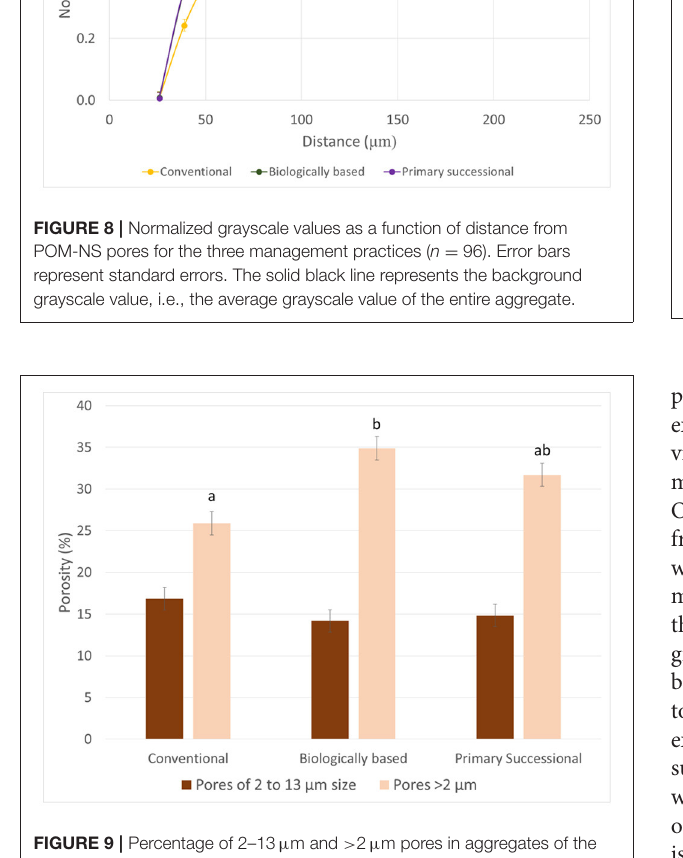
FIGURE 9 | Percentage of 2–13 µ m and > 2 µ m pores in aggregates of the three managements. Letters indicate significant differences between managements for > 2 µ m pores at α = 0.05. The differences in 2–13 µ m pores were not statistically significant. Error bars represent standard errors.